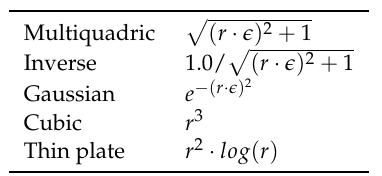
Table 1. Radial basis